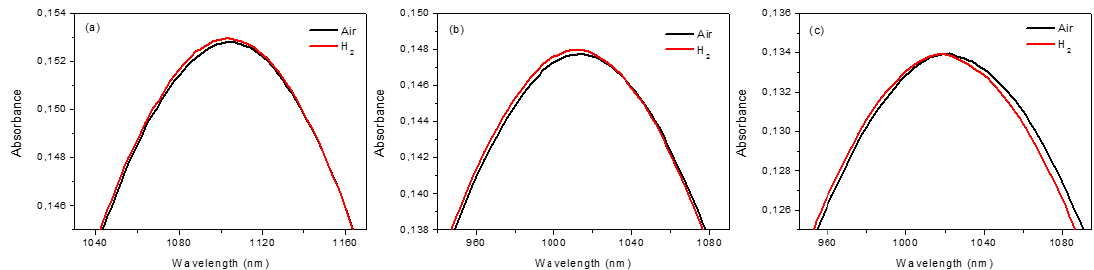
Figure 3. Optical absorption spectra for Au NDs at ( a ) 30 ◦ C, ( b ) 100 ◦ C, and ( c ) 150 ◦ C operative temperature in air (black line) and in H 2 (red line).